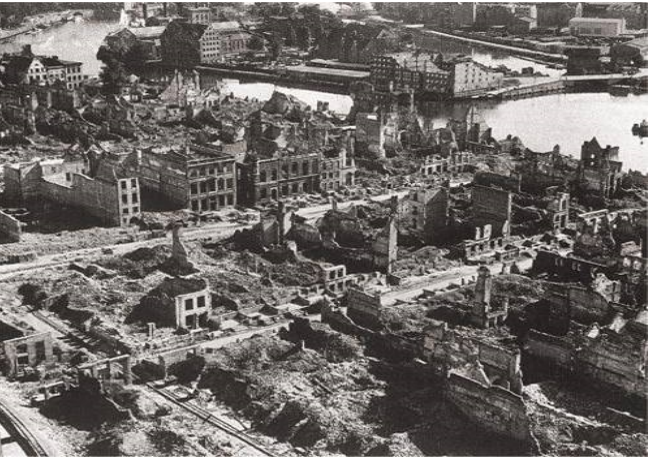
Figure 7. Photograph of damage in Gdańsk after the Second World War [50].